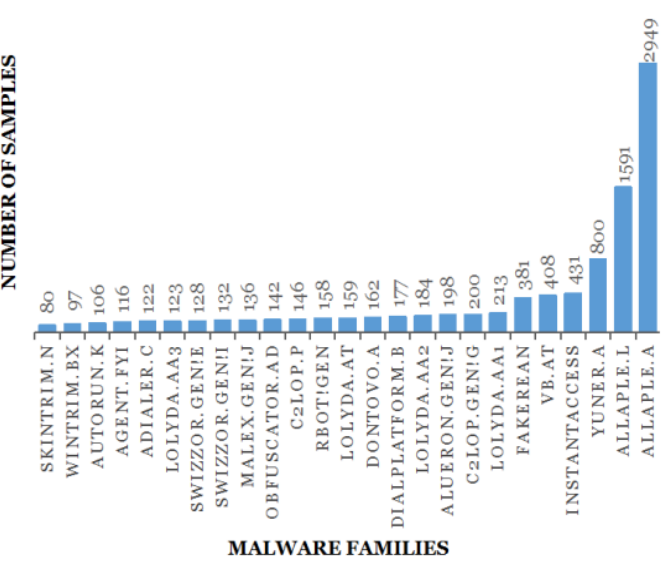
Figure 4. Visualization of the frequency of different variants of malware in the Malimg dataset.